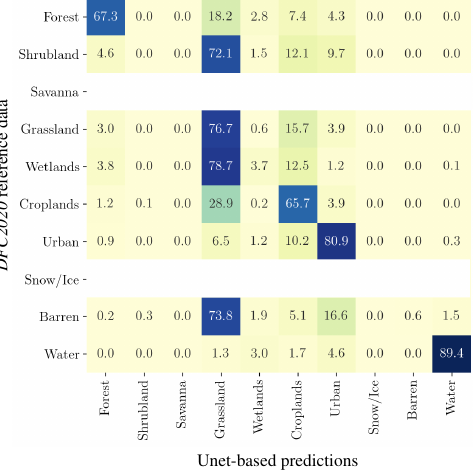
Figure 4. Confusion matrix of the Unet model using only Sentinel-2 data as input.